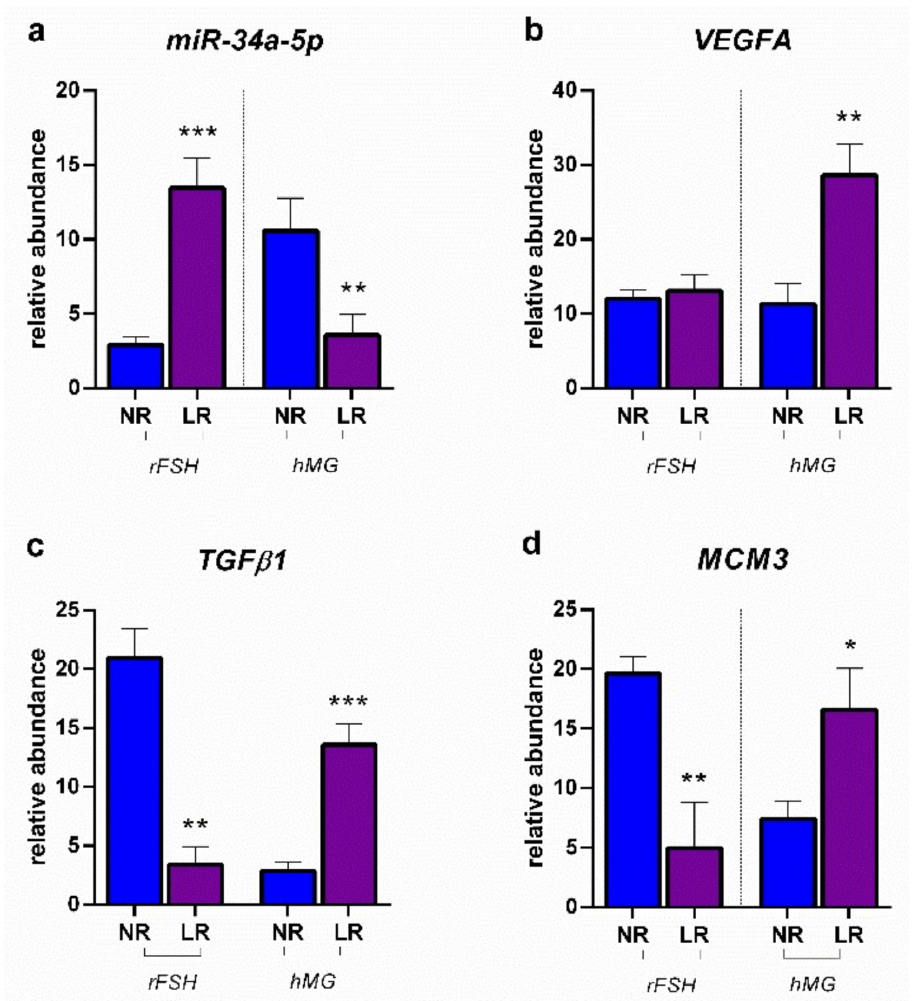
Figure 6. Expression profiles: ( a ) miR-34a-5p; ( b ) VEGFA : vascular endothelial growth factor; ( c ) TGF β 1 : transforming growth factor beta 1; ( d ) MCM3 minichromosome maintenance complex component 3. Results are reported as mean ± standard deviation. Statistical significance was set at p < 0.05 and calculated by Student’s t-test. Asterisks above columns indicate statistical differences between NR and LR groups. * = p < 0.05; ** = p < 0.01; *** = p <